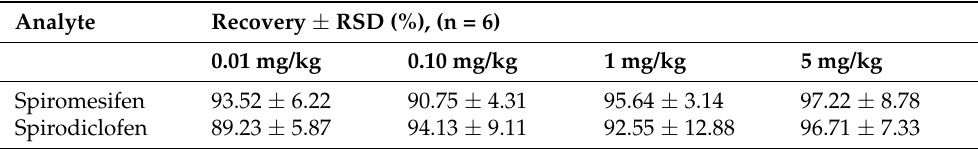
Table 3. Recovery and RSD of spiromesifen and spirodiclofen in tomato